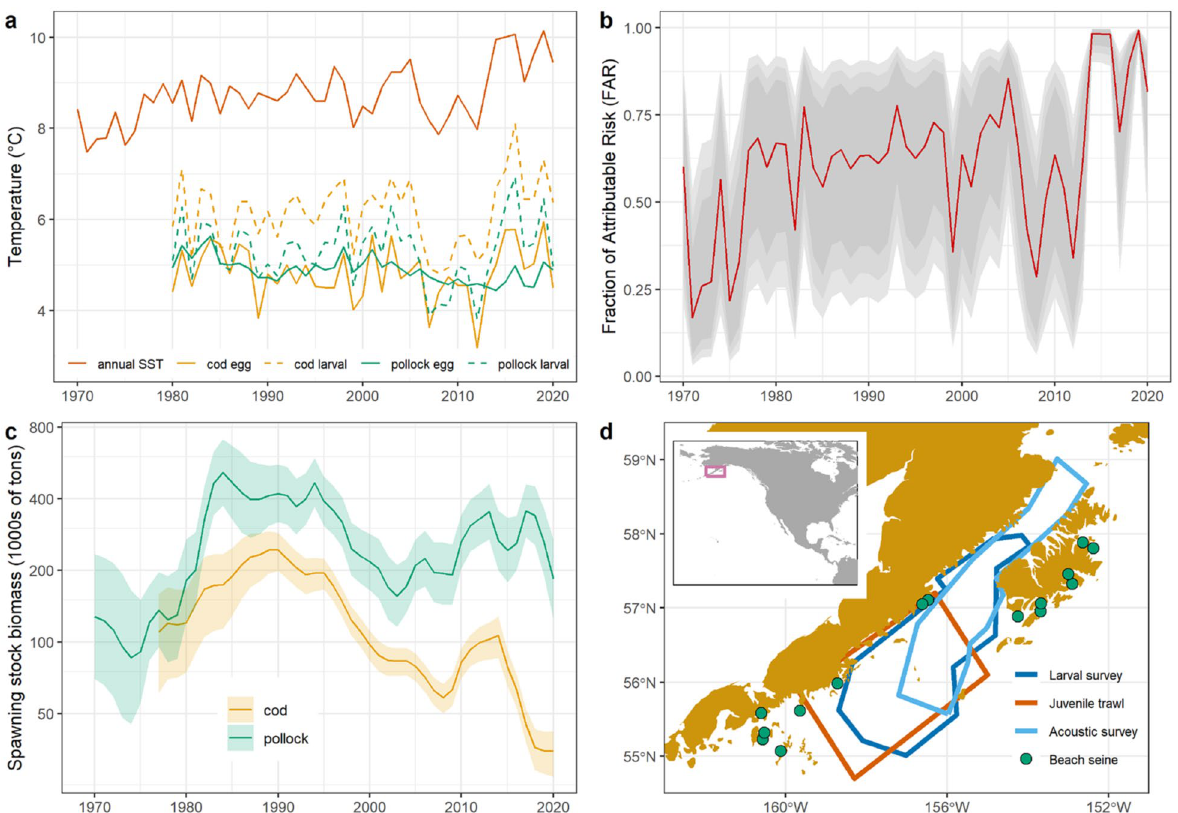
Figure 1. Study system: the Gulf of Alaska Pacific cod and walleye pollock fisheries. ( a ) Temperature time series for annual Gulf of Alaska sea surface temperature (SST), and specific seasons and depths for early life history stages (cod egg = January–April 105 m, cod larval = April–June 15 m, pollock egg = March–May 262 m, pollock larval = March–April 65 m and May–June 25 m). ( b ) Fraction of attributable risk (FAR; 1—preindustrial probability/current probability) for annual Gulf of Alaska sea surface temperature, 1970–2020, mean and 80%/90%/95% CI from Bayesian model comparing ERSSTv5 observations with simulated preindustrial values from five CMIP5 models. ( c ) Estimated spawning stock biomass from age-structured population models 31,32 with 95% CI (for pollock) and ± 2SD (for cod). Note log scale on y-axis. ( d ) Study area, with locations for field data collection. Inset shows study area (magenta box). Map created in R 4.0.2 69 , http:// www.r- proje ct.